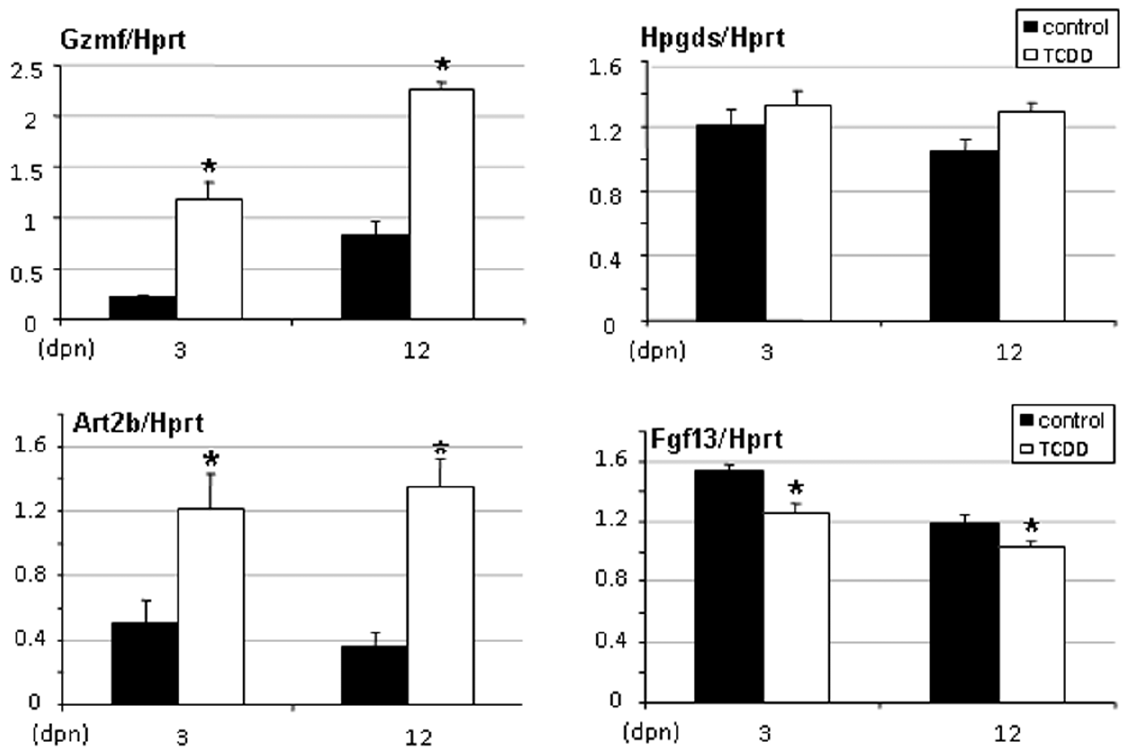
Figure 6. Gzmf, Art2b, Hpgds and Fgf13 gene expression levels in pituitaries of rats exposed in utero to TCDD. Pituitaries were recovered from females of 3 to 12 days of age. Levels were normalized using Hprt. Values are the mean 6 SEM of n=4 animals. *p , 0.05 versus its time-matched control. (dpn), days postnatal.